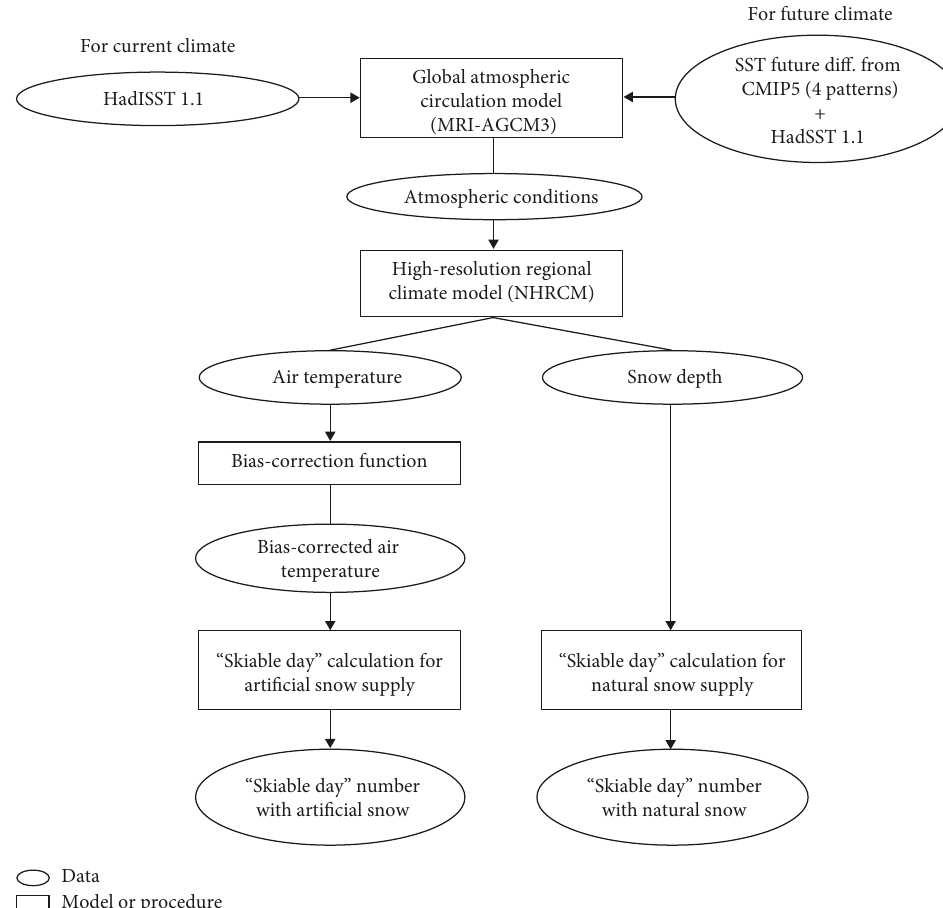
Figure 3: Methodological framework of “skiable day” projections using dynamical